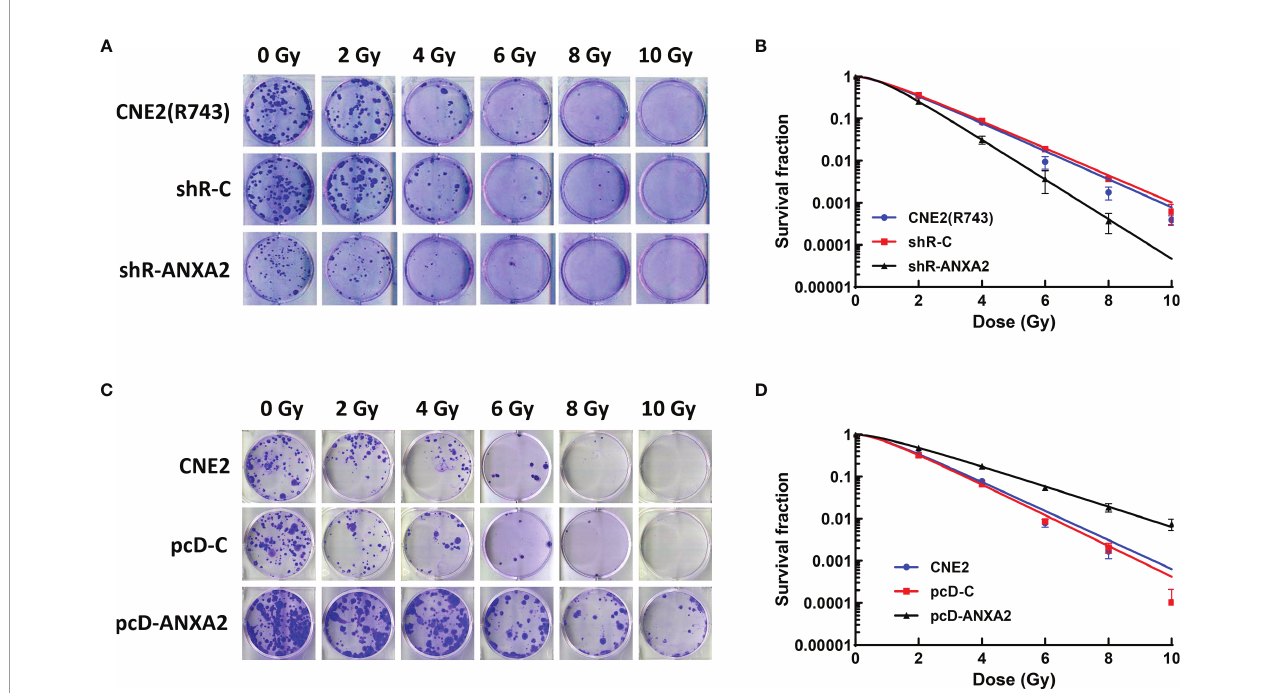
FIGURE 3 | ANXA2 knockdown increases radiosensitivity of NPC cells and ANXA2 overexpression decreases radiosensitivity of NPC cells. (A) clonogenic survival assay reveals less cell colonies in shR-ANXA2 cells than in shR-C and CNE2(R743) cells following exposure to X-ray irradiation at doses of 0, 2, 4, 6, 8 and 10 Gy; (B) the radiosensitivity is increased in shR-ANXA2 cells than in shR-C and CNE2(R743) cells following exposure to X-ray irradiation at doses of 0, 2, 4, 6, 8 and 10 Gy; (C) clonogenic survival assay shows more cell colonies in pcD-ANXA2 cells than in pcD-C and CNE2 cells following exposure to X-ray irradiation at doses of 0, 2, 4, 6, 8 and 10 Gy; (D) a decrease is seen in the radiosensitivity in pcD-ANXA2 cells relative to pcD-C and CNE2 cells. All results are given as mean ± SD obtained from three independent